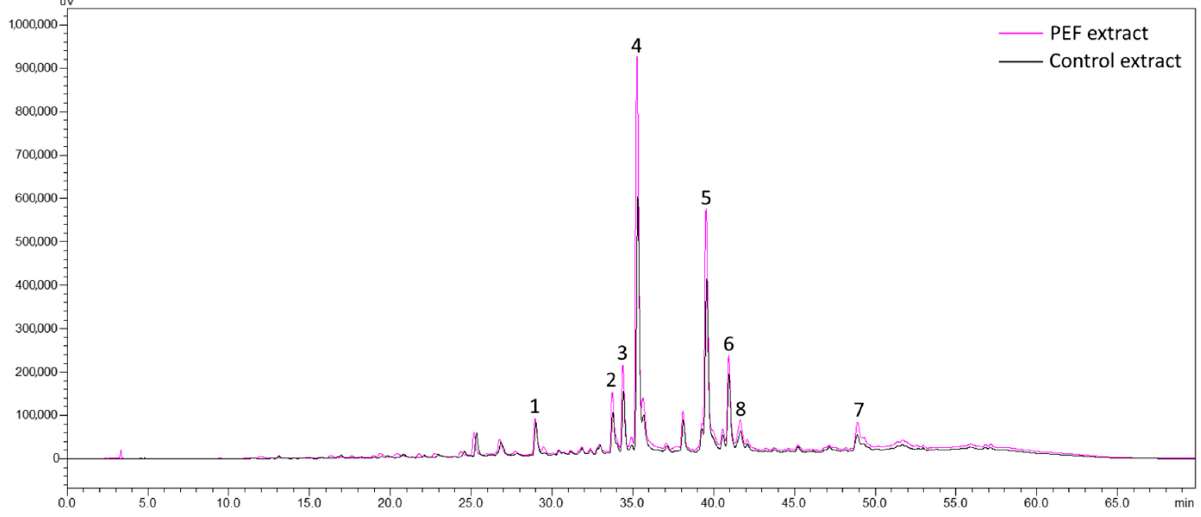
Figure 2. Overlay of chromatograms of PEF and control extracts with t pulse 10 µ s and T 1000 µ s. Peak 1: Luteolin diglucoside; Peak 2: Quercetin-3- O -rutinoside; Peak 3: Luteolin rutinoside; Peak 4: Luteolin-7- O -glucoside; Peak 5: Apigenin-7- O - rutinoside; Peak 6: Luteolin-3 ′ - O -glucoside; Peak 7: Luteolin aglycone; Peak 8: Oleuropein. Table 3. Major compounds concentration (mg g − 1 dw) of OLL extracts prepared with 25% aqueous ethanol for extraction duration of 15 min. Exp.